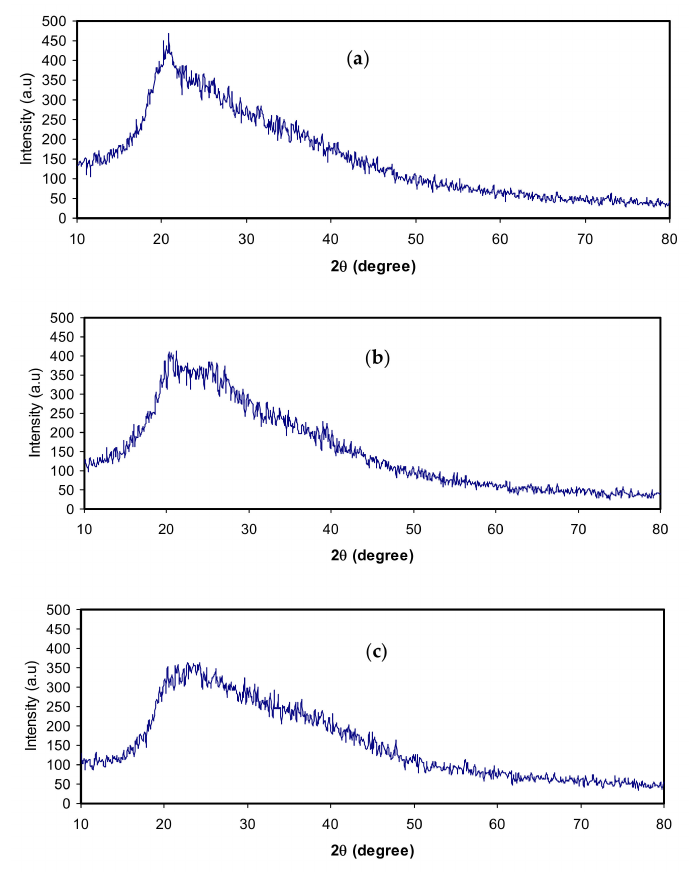
Figure 5. XRD pattern for ( a ) CSGL 1, ( b ) CSGL 2, and ( c ) CSGL 3.